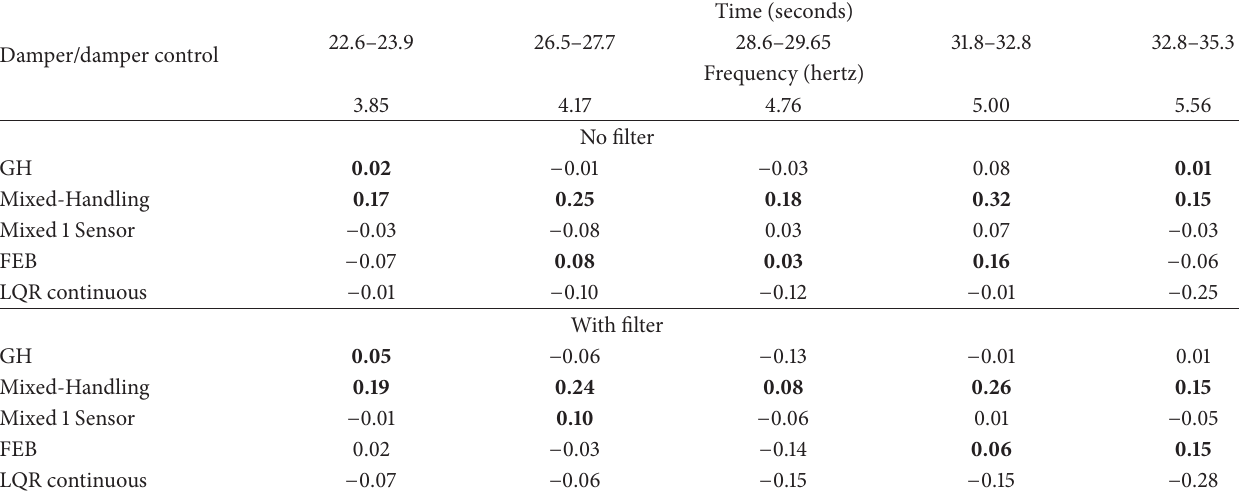
Table 4: BOGGS test, constant speed improvement index (higher is